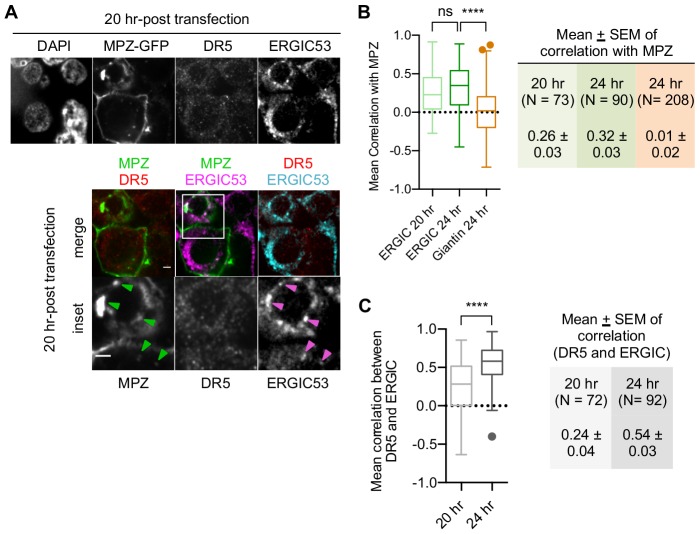
Misfolded protein accumulation in the ERGIC precedes DR5 retention in the ERGIC.(A) Immunofluorescence for DR5 and ERGIC53 in HCT116 fixed 20 hr post-transfection. ERGIC53 is magenta in the overlay with MPZ (green) or cyan in the overlay with DR5 (red) (scale bar = 5 μm). Arrows in inset images depict regions where MPZ and ERGIC53 signal overlap (scale bar = 2 μm). (B) Quantification of Pearson’s correlation per cell between ERGIC and MPZ, or Giantin and MPZ of fixed HCT116 cells at the specified time after MPZ-GFP transfection. Whisker-box plots depict the Tukey method. Statistics were performed through unpaired two-tailed t-tests, where **** indicates p<0.001 and ns means not significant, and the variance was non-significant. (C) Quantification of Pearson’s correlation per cell between DR5 signal and ERGIC53 of fixed HCT116 cells at 20 hr and 24 hr post-transfection with MPZ-GFP. Whisker-box plots depict the Tukey method. Statistics were performed through unpaired two-tailed t-tests, where **** indicates p<0.001 and the variance was non-significant.